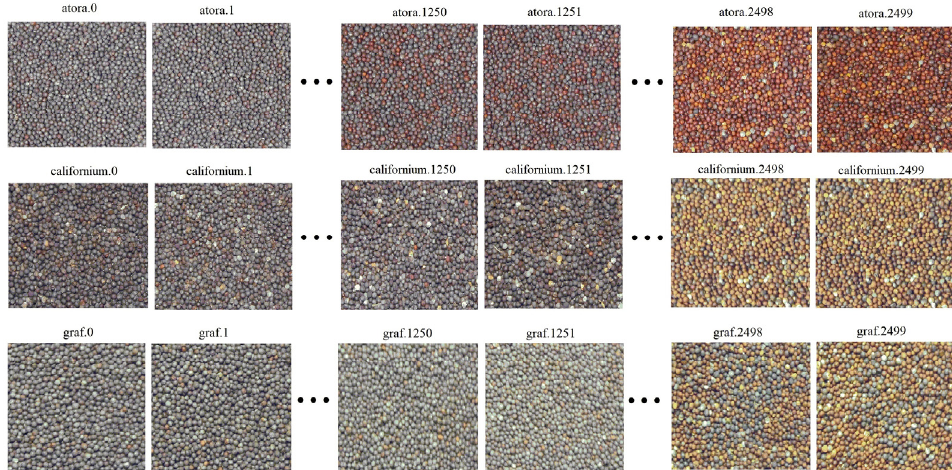
Table 2. Description of arboricultural seed classification models.